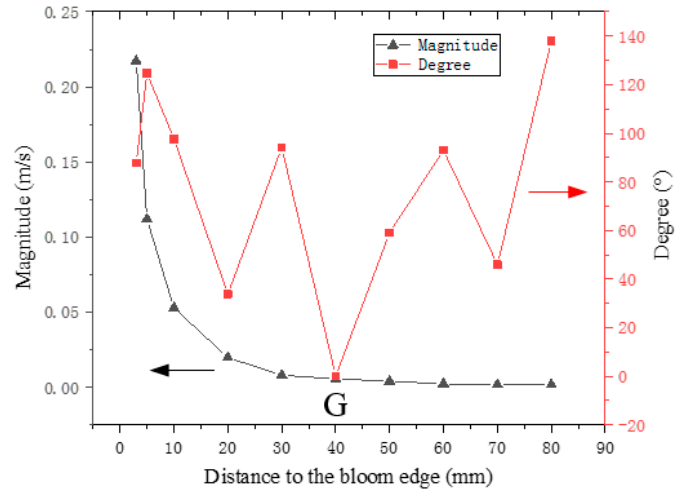
θ of interdendritic fluid flow velocity θ at G position is zero.)